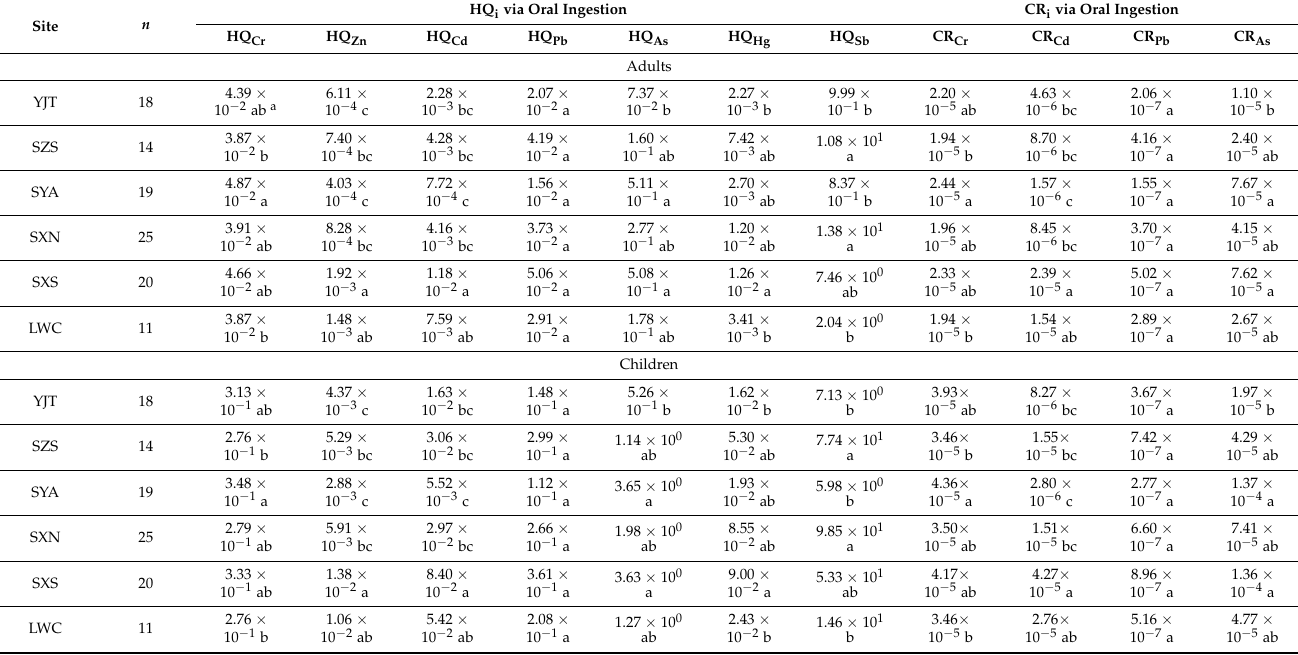
a The values shown are mean. Different lowercases represent significant difference ( p < 0.05) of the same group (adults and children) in different sampling sites, while the same lowercases show no significant difference. The same as